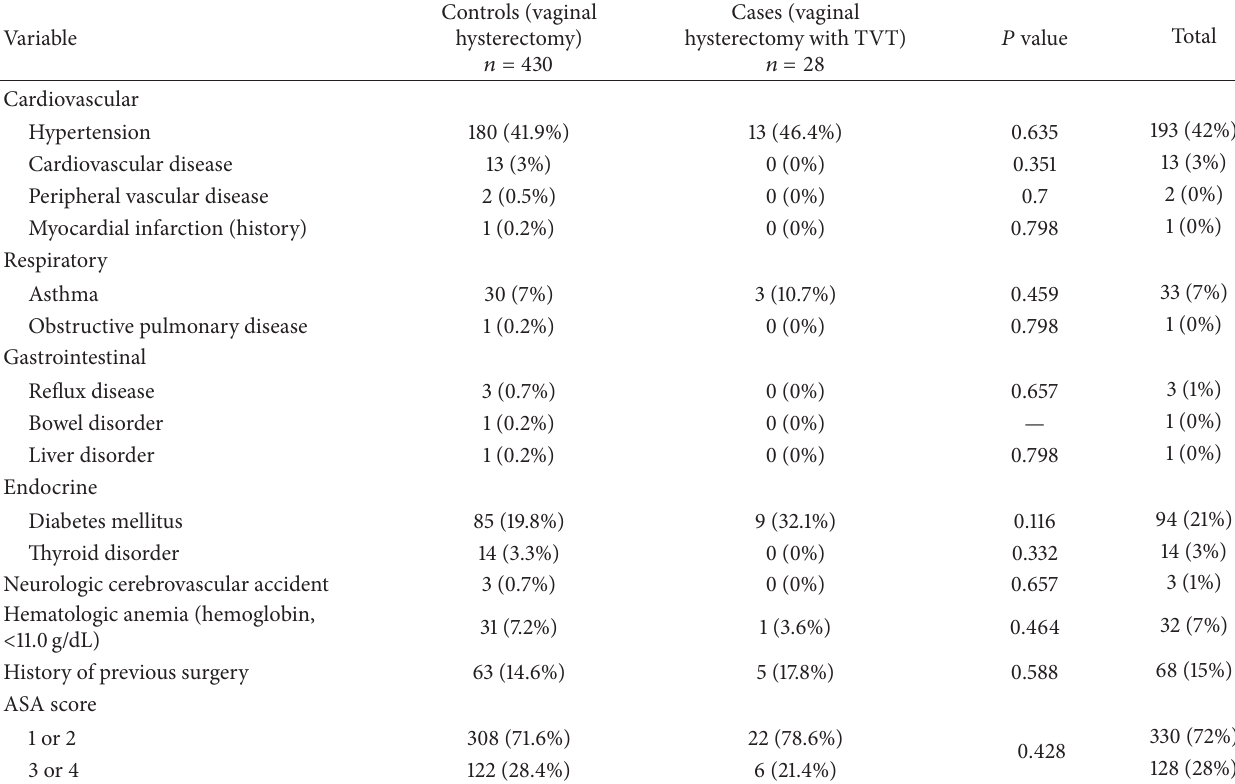
Table 2: Comorbidities of cases (vaginal hysterectomy with TVT) and controls (vaginal hysterectomy). Variable